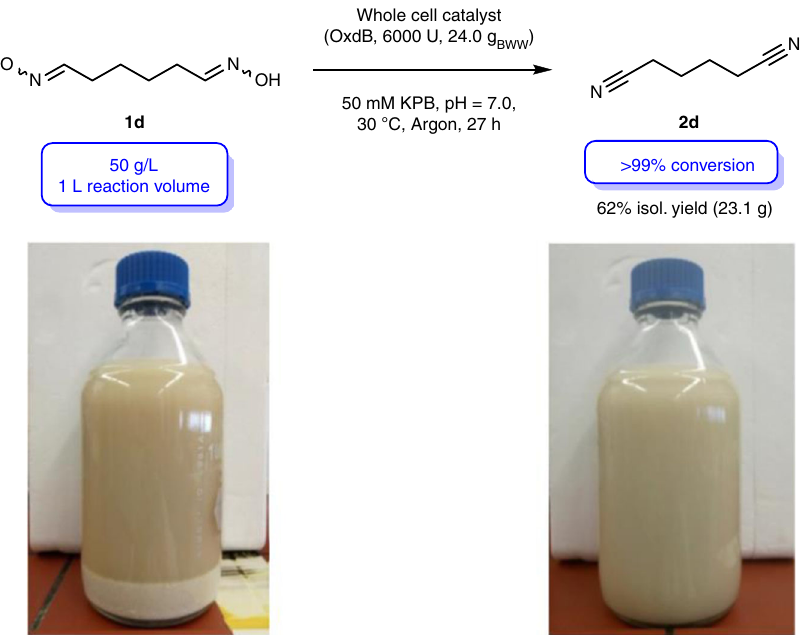
Fig. 6 Synthesis of adiponitrile ( 2d ) at a substrate loading of 50 g/L on liter scale. The photos show the reaction mixture at the start of the reaction and after a reaction time of 27 h, at which the solid substrate is completed